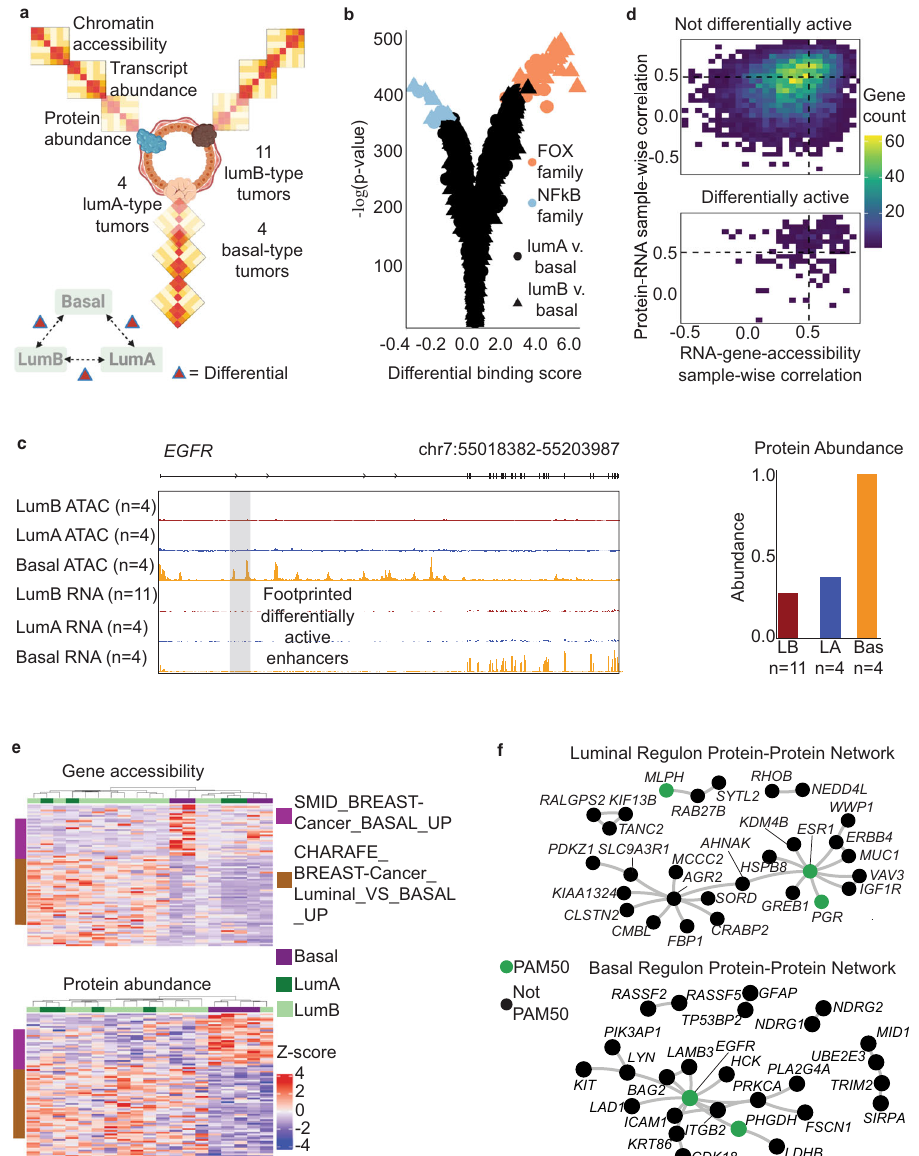
Fig. 5 Application of analytical framework to breast cancer cohort. a Cohort characteristics, includes 19 breast cancer (BRCA) samples (11 luminal B, 4 luminal A, and 4 basal). b Differential transcription factor footprints between luminal A/B and basal subtypes. c Visualization of gene accessibility and transcript and protein abundances for EGFR in BRCA subtypes. Biologically independent tissue chunks from each disease group (i.e., lumA, lumB, and basal) are averaged to produce the signal plots. The gray highlighted region on the signal track indicates footprinted differentially active enhancers d Density of sample-wise correlation between gene accessibility and expression for not differentially active genes (top) compared to differential active genes (bottom). e Heatmaps of gene accessibility (top) and protein abundance (bottom) for genes that are differentially expressed and contain gene body enhancers. Annotation bars delineate samples ’ subtypes (top bar) and gene membership in known breast cancer gene sets (left bar). f Protein – protein interaction networks for luminal regulons (top) and basal regulon (bottom). Green dots mark known PAM50